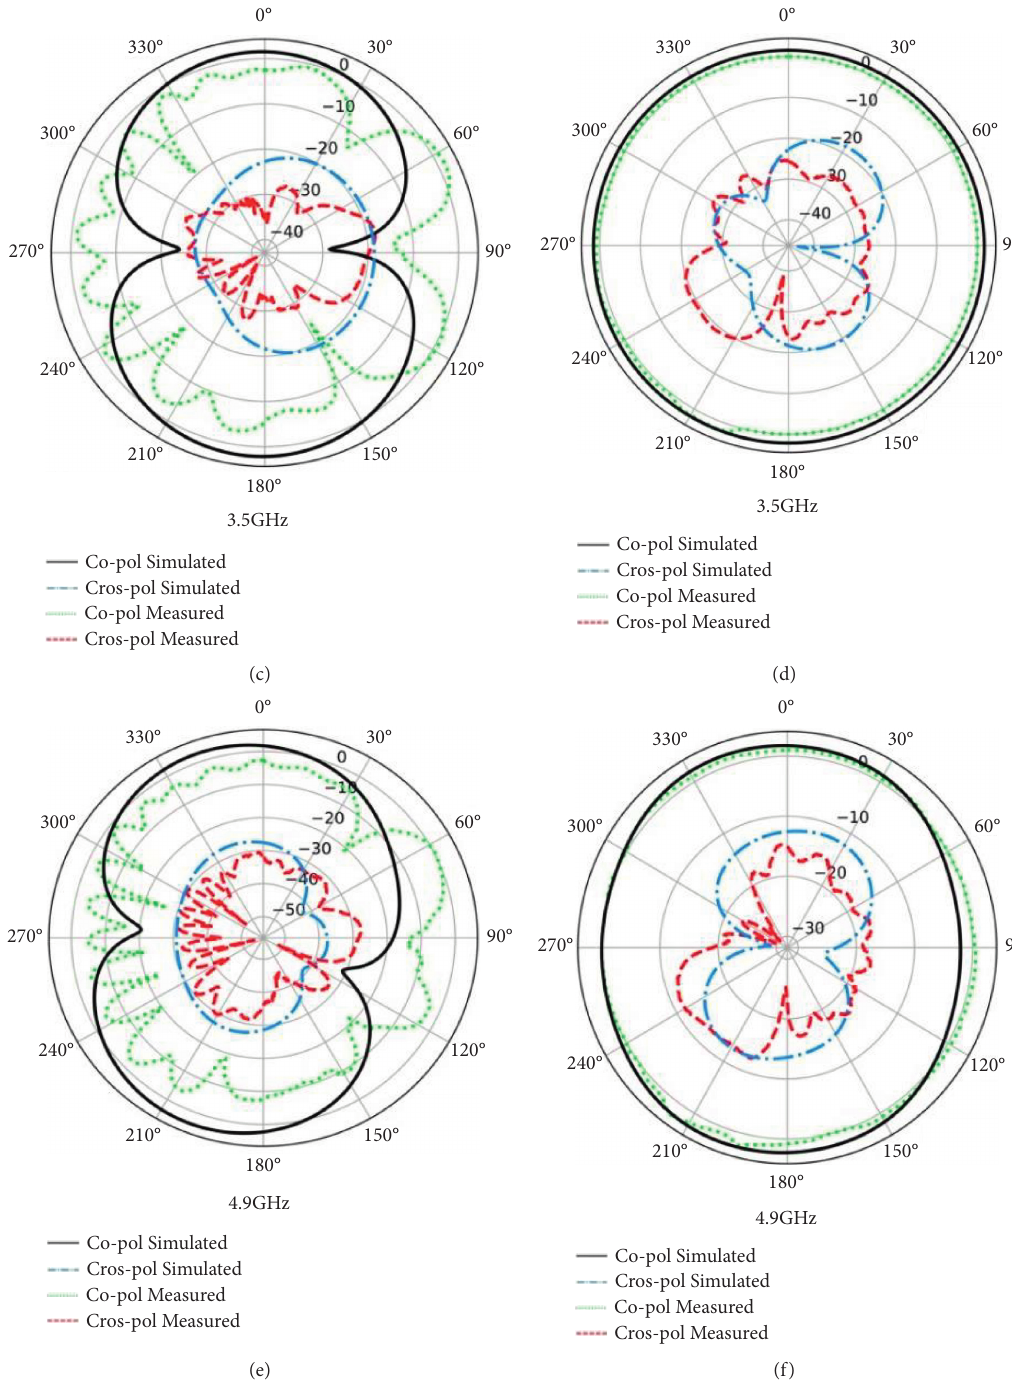
Figure 8: Simulated and measured 2D (a) co-polar and (b) cross-polar radiation